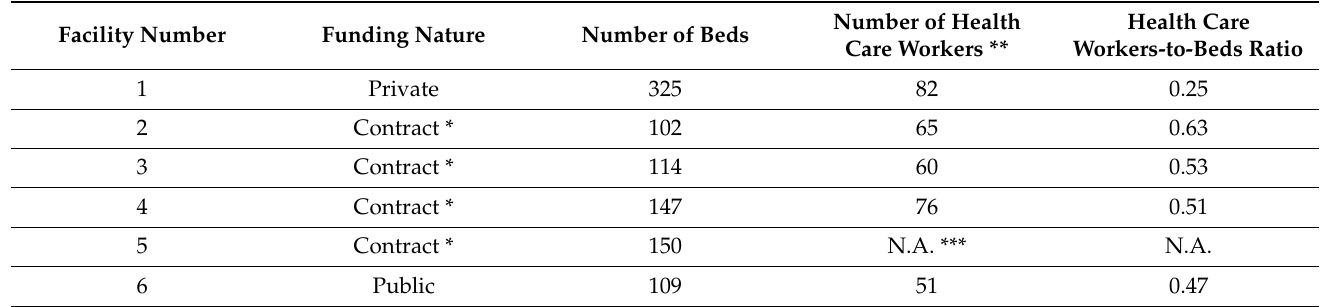
Table 2. Characteristics of residential care homes ( n = 6).